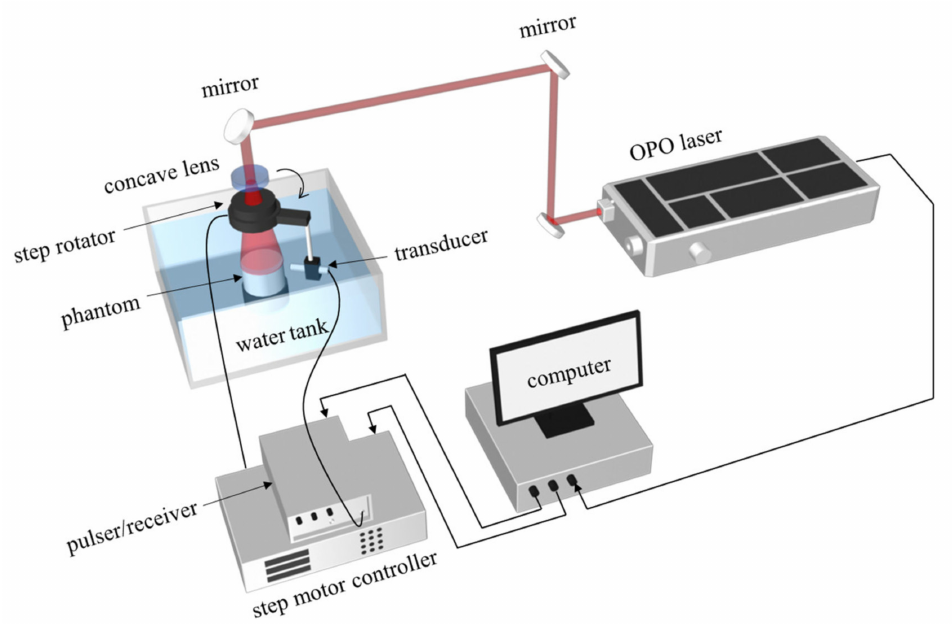
Figure 3. Schematic of the 2D PAT system.